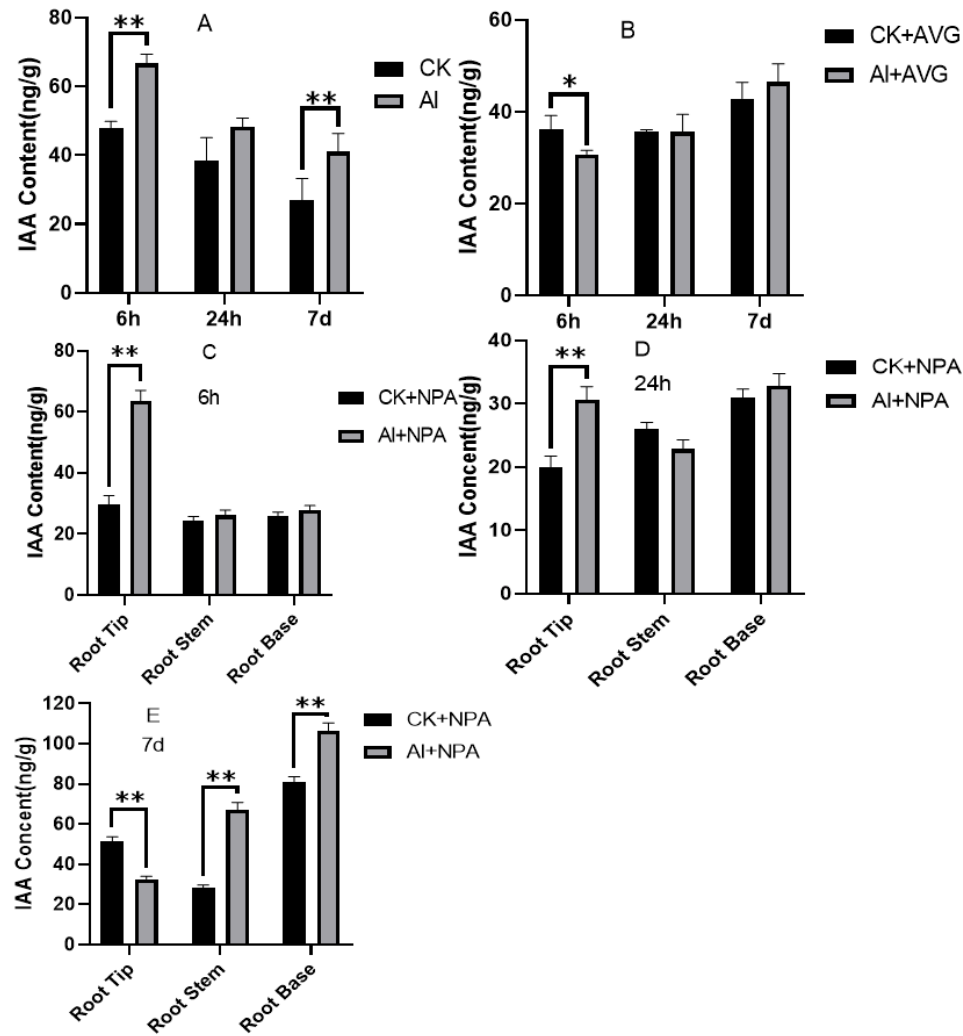
Figure 3. A comparison of changes in IAA content in the tea roots with and without Al treatment and with IAA synthesis and transport inhibitors. ( A ) Time course of the difference in IAA content in the root tips with and without Al treatment; ( B ) Time course of the difference in IAA content in the root tips with the IAA synthesis inhibitor AVG, with and without Al treatment; ( C ) The difference in IAA content in the root tips, root stems, and root base after 6 h with the IAA transport inhibitor NPA, with and without Al treatment; ( D ) The difference in IAA content in the root tips, root stems, and root base after 24 h with the IAA transport inhibitor NPA, with and without Al treatment; ( E ) The difference in IAA content in the root tips, root stems, and root base after 7 d with the IAA transport inhibitor NPA, with and without Al treatment (*, ** indicate significance at 0.05 and 0.01 probability levels, respectively).